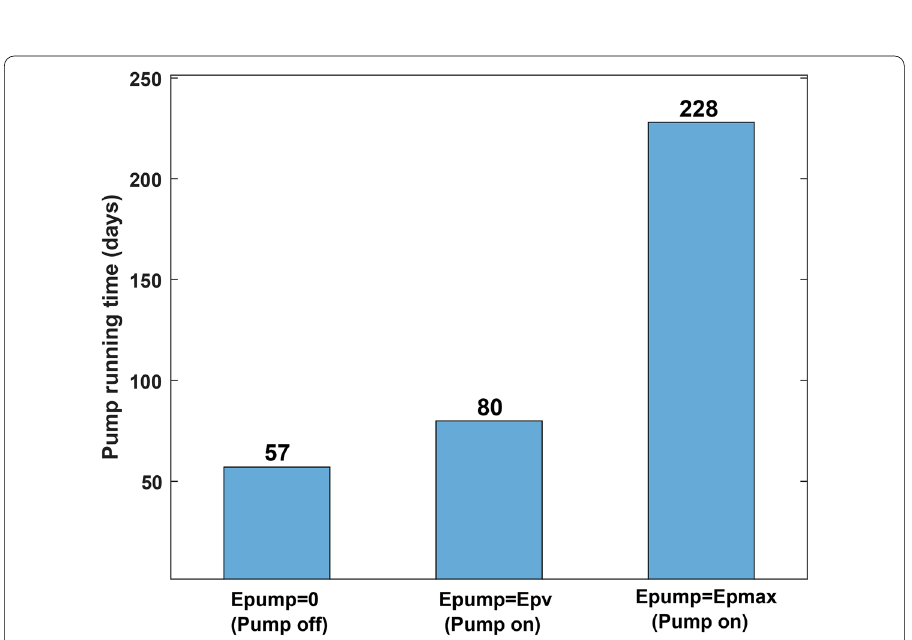
Fig.12 Distribution of Pump running time over one year for the optimal configuration corresponding to LWSP of